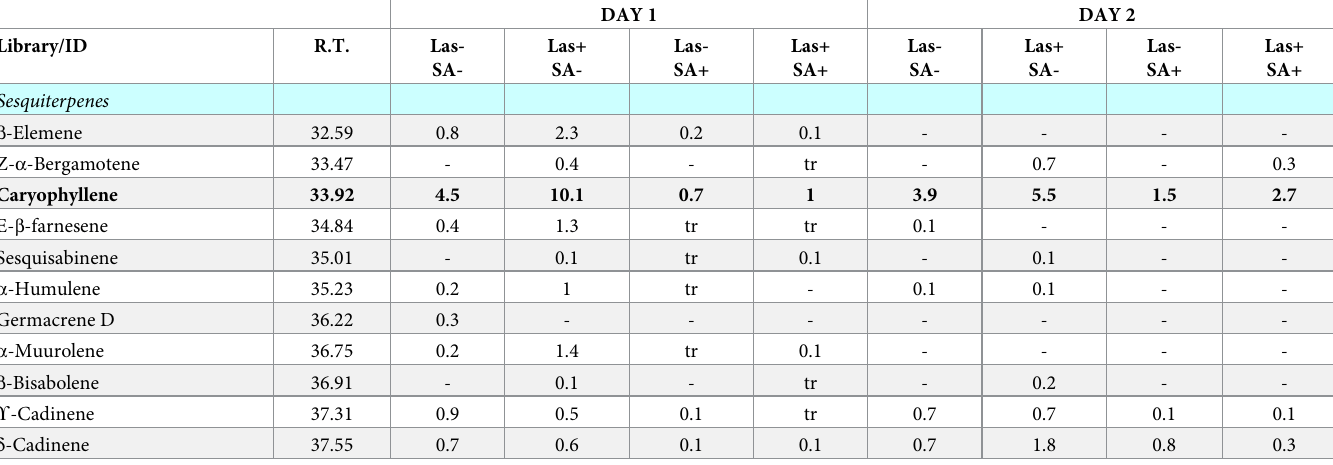
Chemical class proportionality in the different SA experimental treatments was also influ- enced by the three main effects SA application and collection day but not by Las status (S5 Table). There was also a significant interaction effect of SA x Day. The analysis of similarities procedure (ANOSIM) likewise indicated that Las infection did not influence chemical class proportionality (ANOSIM global R = -0.078, NS) while SA treatment had a very strong effect (ANOSIM global R = 0.731, P (cid:20) 0.0001) and collection day had a moderate influence (ANO- SIM global R = 0.222, P (cid:20) 0.004). Similarity of percentages analysis (SIMPER) showed that methyl salicylate contributed the most to the (dis)similarity between treatments (42.47%). A relatively large contribution was also made by alkyl aldehydes (20.56%), while moderate con- tributions were made by monoterpenes (15.16%) and sesquiterpenes (13.75%)(Fig 4; S6 Table)